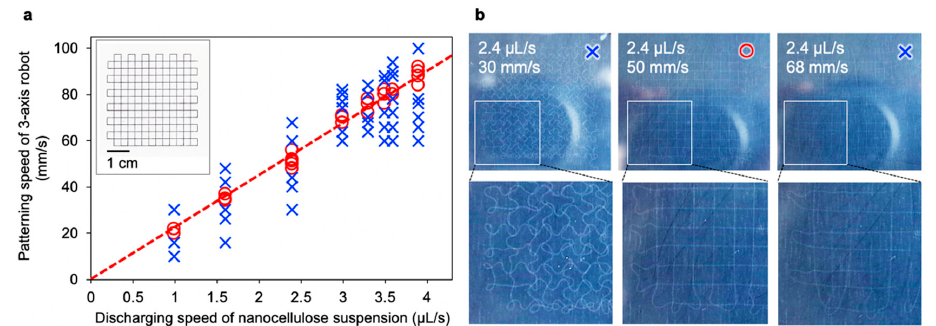
Figure 2. Optimal discharging and patterning speeds. ( a ) Mapping diagram of the patterning compatibility between the discharging speed of the nanocellulose suspension and the patterning speed using syringe needle 25G (internal diameter of 0.25 mm). The red circle and blue cross indicate the patterning results of the nanocellulose suspensions showing high and low followability to the programmed model pattern (insert), respectively. The dashed red line is the best fit to the red circles. The insert shows the one-stroke grid model for judging the drawing followability, which was drawn by the three-axis robot with a ballpoint pen on paper; ( b ) Patterned nanocellulose gels in acetone coagulation baths produced with various discharging and patterning speeds.